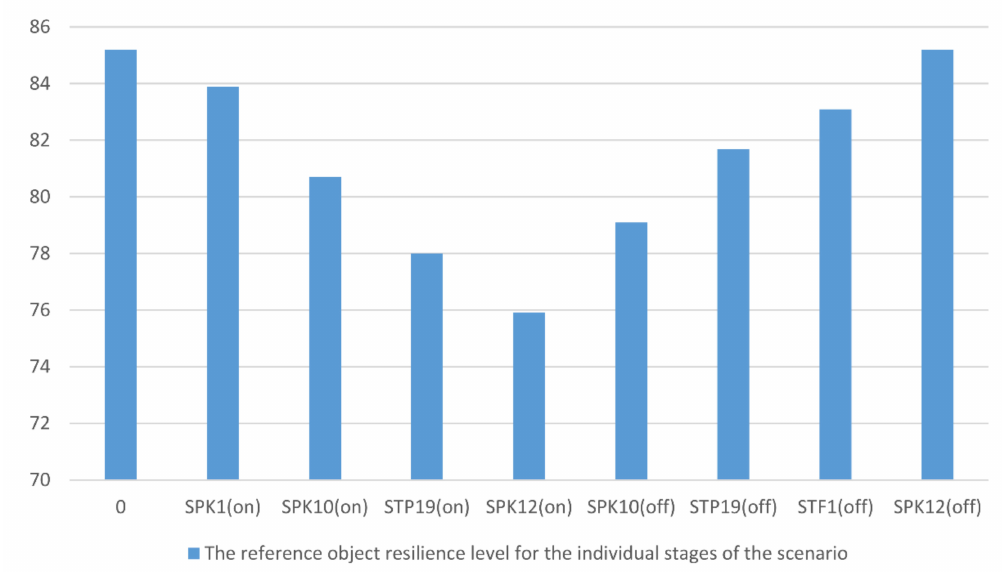
Figure 5. Reference Object Resilience Progression in the Context of Individual Dynamic Penalty Factors Application